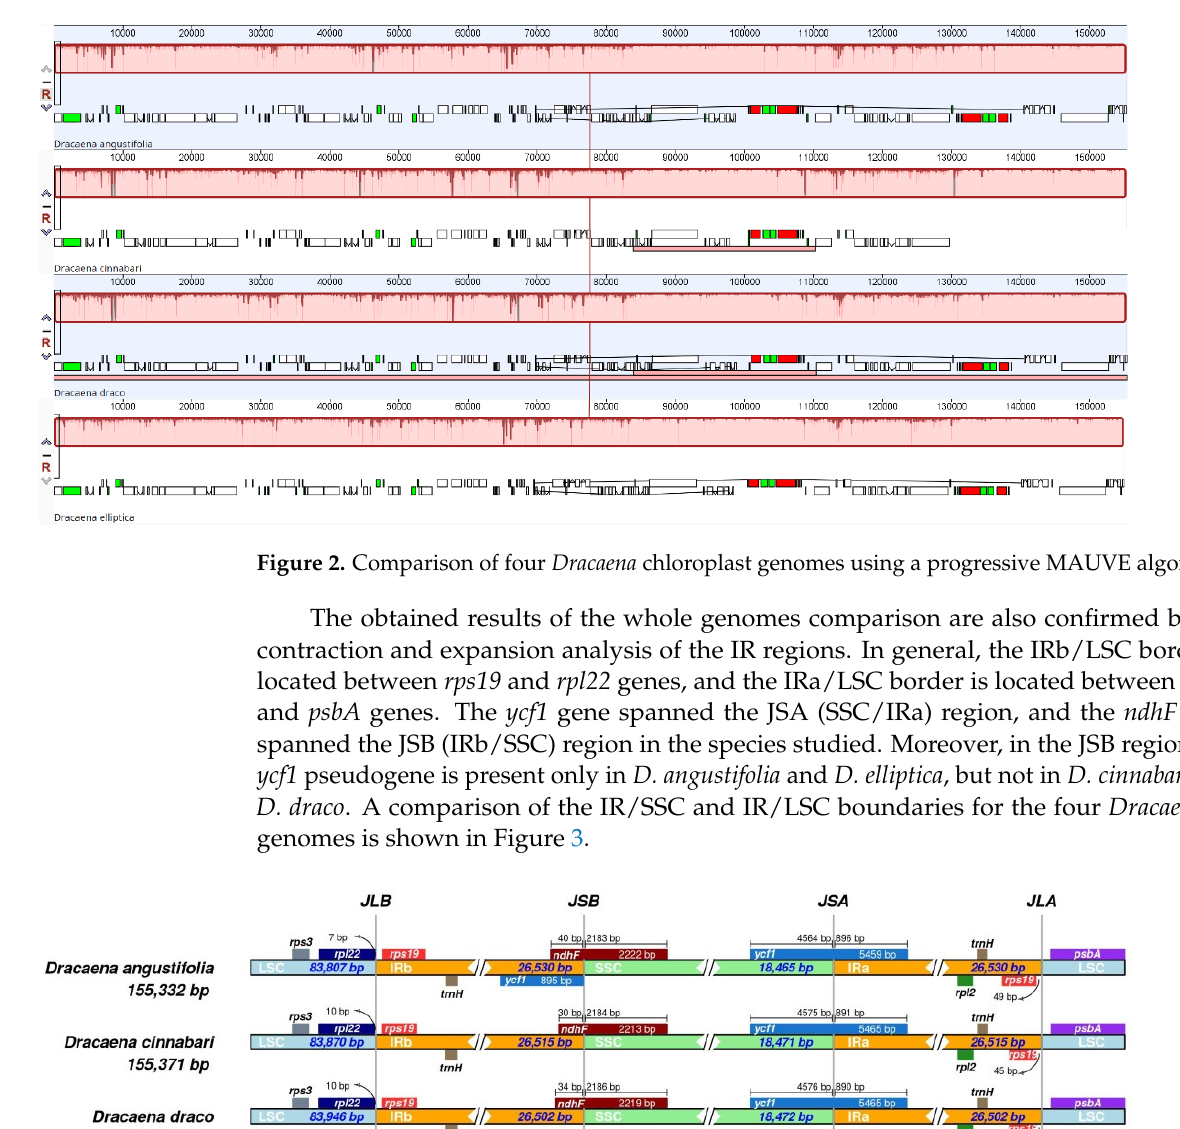
Table 3. Characteristics of SSRs present in the four Dracaena chloroplast genomes.